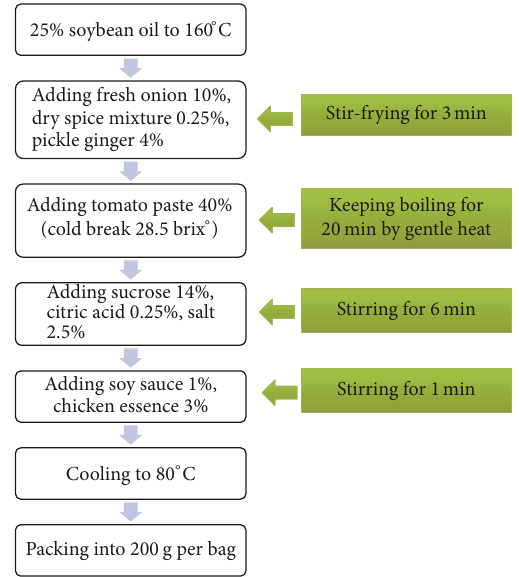
Figure 1: Tomato hot pot sauce making